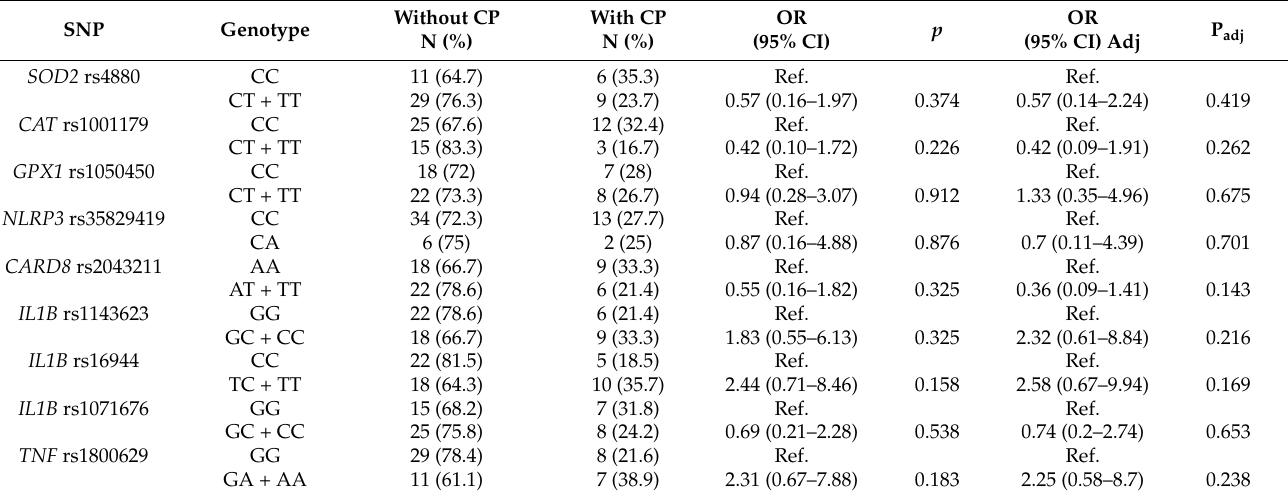
Table 5. The association of common polymorphisms with cerebral palsy